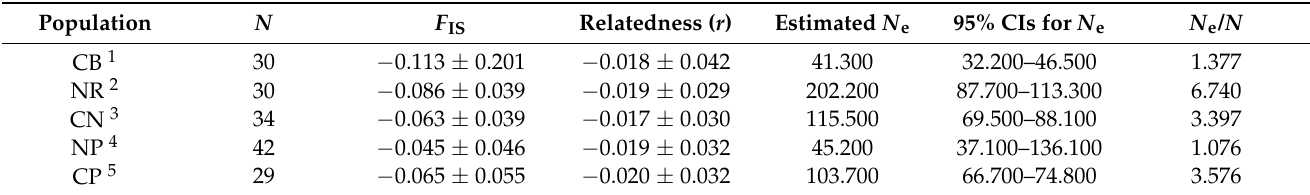
Table 4. Inbreeding coefficients, relatedness, effective population size, and ratio of effective popula- tion size and census population ( N e /N ) of 136 Siamese ( Crocodylus siamensis , Schneider, 1801) [1] and 29 saltwater crocodiles ( C. porosus , Schneider, 1801)